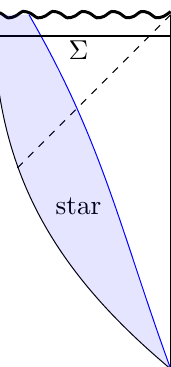
Figure 7 . The Penrose diagram of a pure-state geometry in which matter (a ‘star’) collapses to become a BTZ black hole. On the surface Σ the geometry displays a long ‘throat’ region where the metric is very well-approximated by exact BTZ. On Σ , all details of the original star that collapsed to form the black hole are hidden at the bottom of this